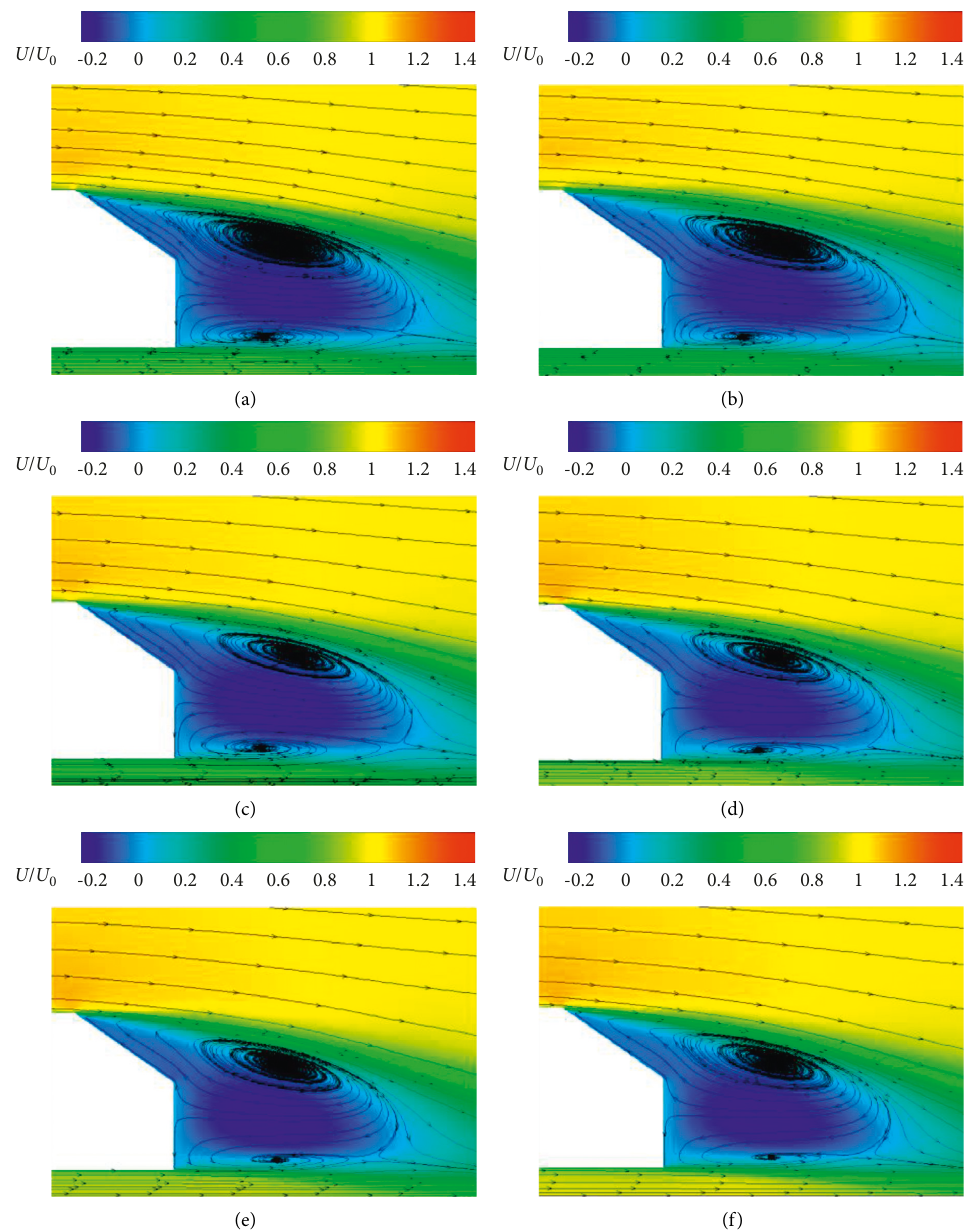
Figure 8: X -direction velocity contour and streamline distribution behind trailing body in two bodies on xz symmetry plane. (a) x/L � 0.25 (b) x/L � 0.5. (c) x/L � 0.75. (d) x/L � 1. (e) x/L � 1.25. (f) x/L �